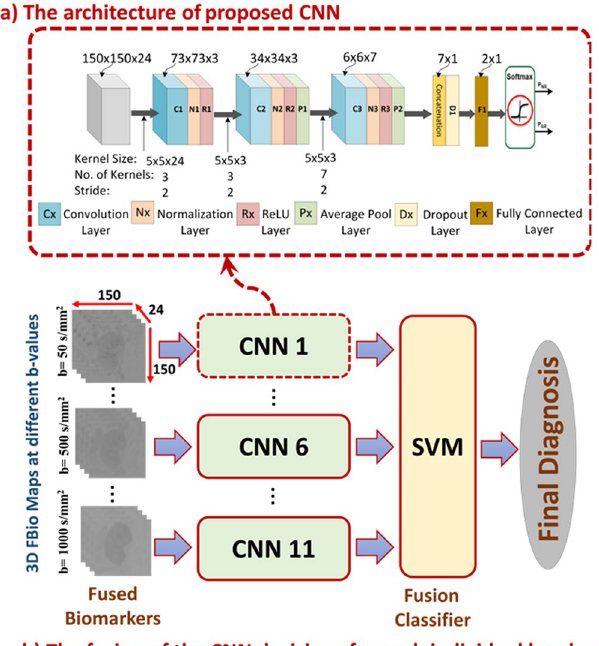
Figure 5. The architecture of the proposed convolutional neural network (CNN), where ( a ) illustrates the configurations of the developed CNN and its layers and ( b ) represents the pipeline of the fusion process using a support vector machine (SVM) classifier. The CNN is trained and validated at each b-value apart from the other b-values. At each b-value, we have 56 samples. Each sample is a 3D volume for a certain subject, and each volume is 150 × 150 × 24 voxels. Each 3D volume is fed to a CNN as one sample of the dataset. The final classification decision is obtained by combining the decisions of all CNNs’ output probabilities at all b-values. This fusion is achieved by a support vector machine (SVM) where each sample has 22 features (2 probabilities for the two classes obtained from the CNN at a specific b-value × 11 b-values).